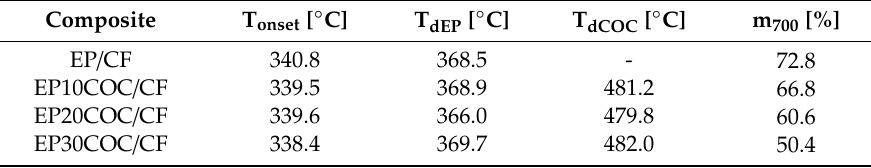
Table 2. Concentration of the constituents in the prepared composite